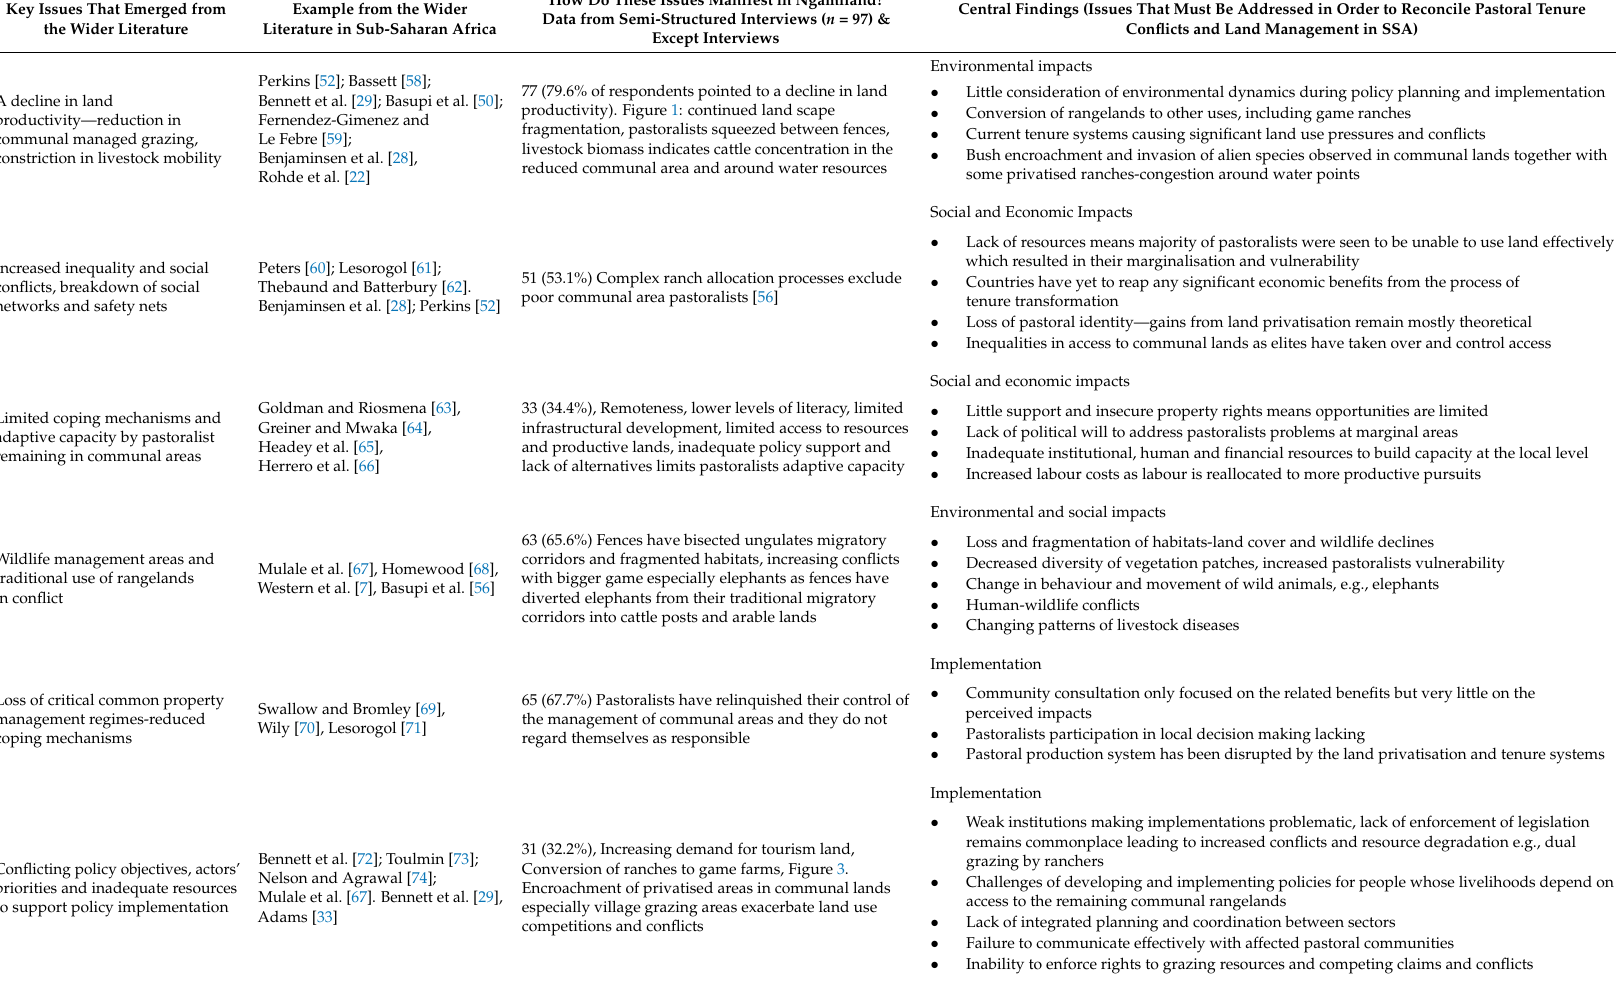
Table 2. Summary of key issues/themes that emerged from the systematic review and how the issues manifest in Ngamiland. Key Issues That Emerged from Example from the Wider the Wider Literature Literature in Sub-Saharan